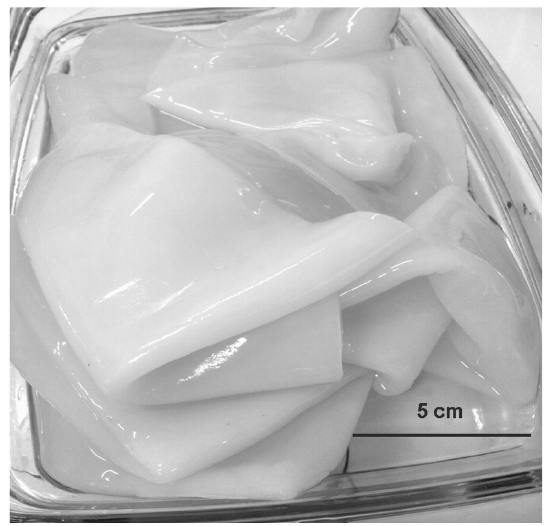
Figure 1. Pellicles of purified BC produced in static